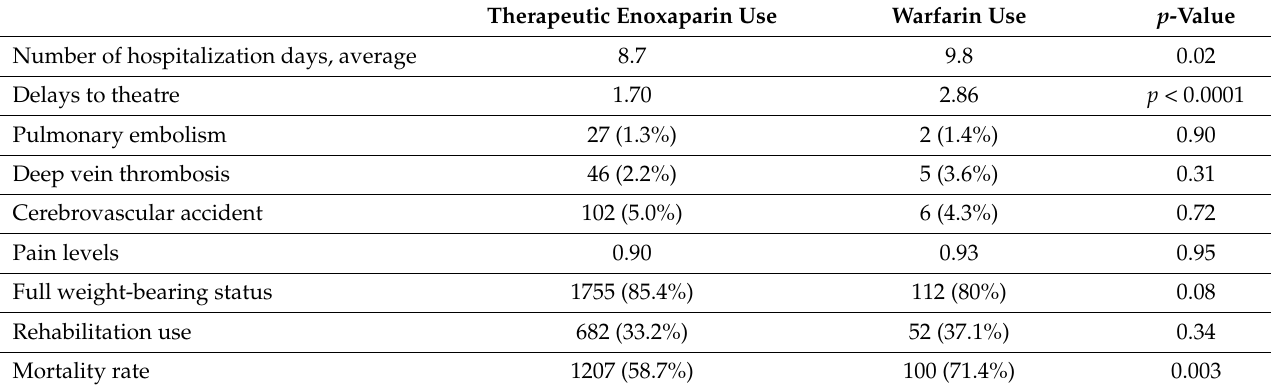
Table 4. Postoperative outcomes between cohorts.